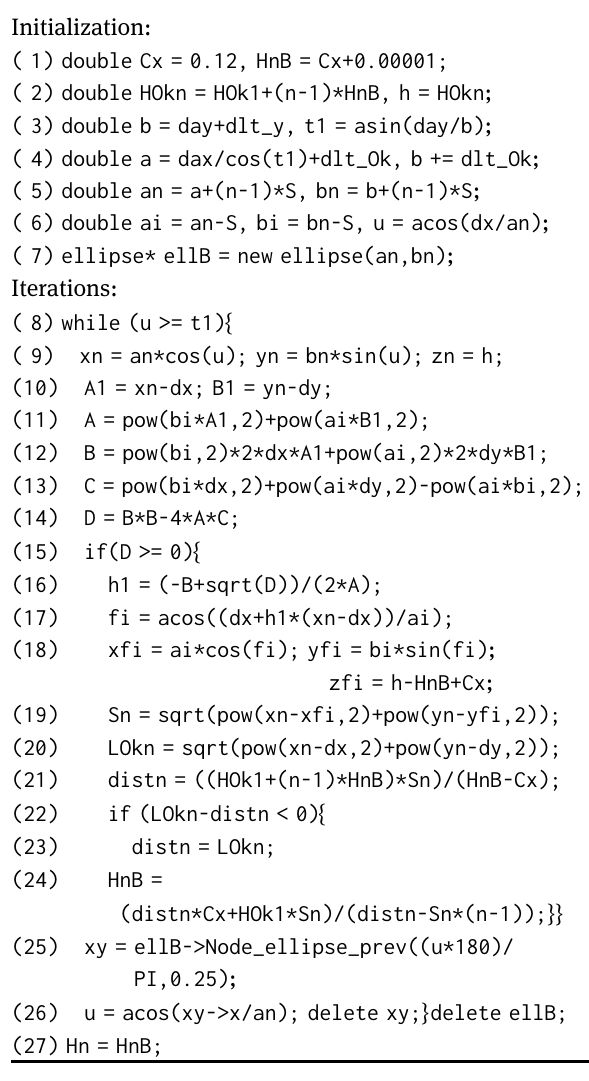
Figure 10: ILSF lines for the n th row in the stand BBI, Focus – the point FO dx dy , , 0 ( )